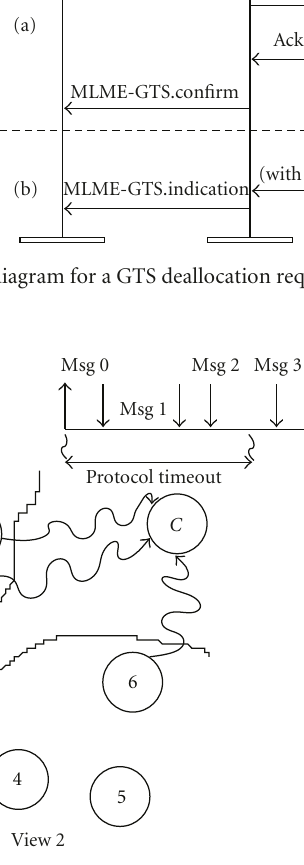
Figure 20: A WSN is detecting the appearance of an event from the integration of 2 not-overlapping views.